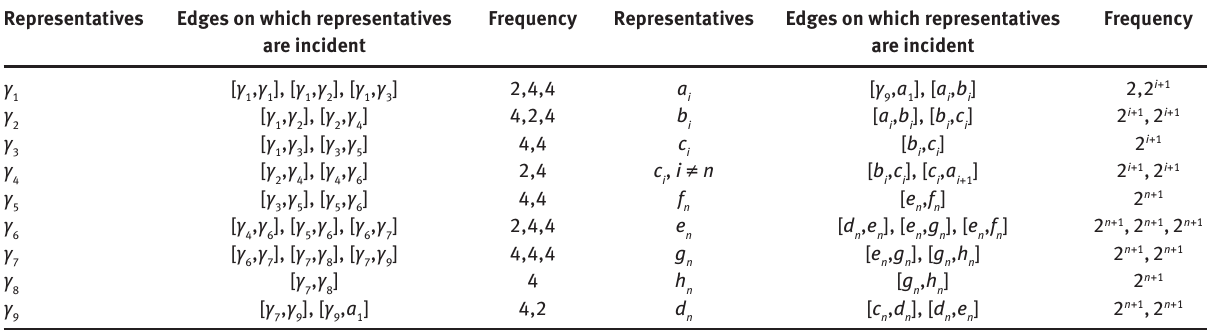
Table 10: Representatives with corresponding edges on which these are incident and their frequencies of occurrence for n ≥ 1.